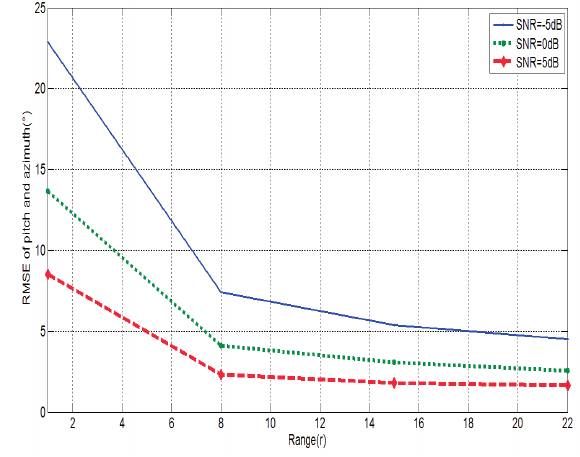
Figure 2. The RMSE sunder different exponential